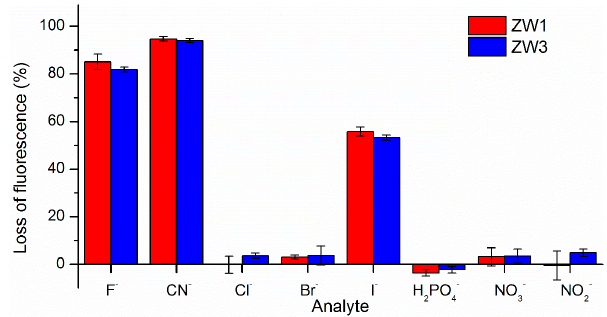
Figure 5. Histogram of the loss of fluorescence intensity registered for acetonitrile solutions of ZW1 and ZW3 ([ ZW ] = 6 × 10 − 6 M, λ exc = 406 nm) upon the addition of 1 equivalent of different anions ([anion] = 6 × 10 − 6 M). The average of three independent experiments is plotted in each case.